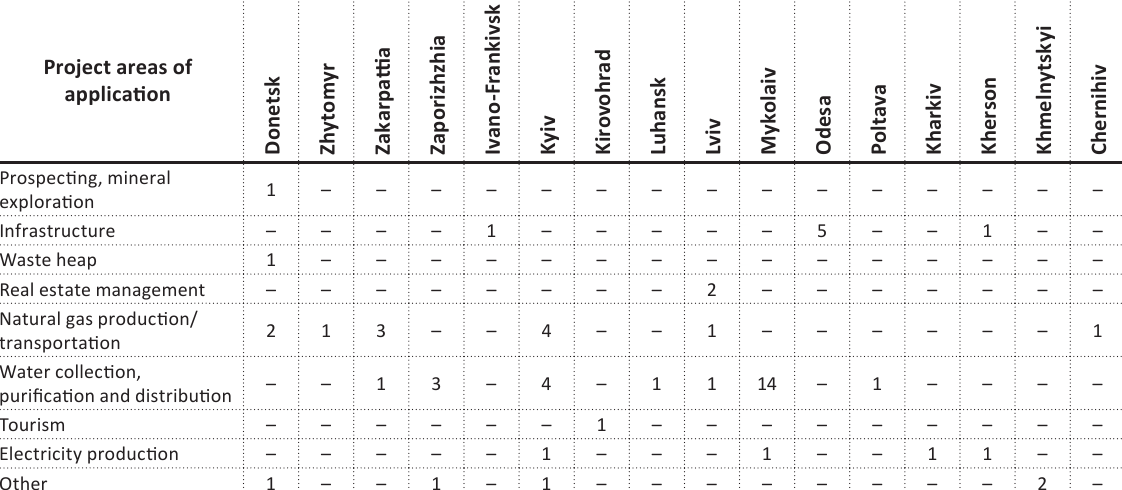
Table 3. The state of PPP implementation in Ukraine Source: Ministry for Development of Economy, Trade and Agriculture of Ukraine (http://www.me.gov.ua ). Project areas of